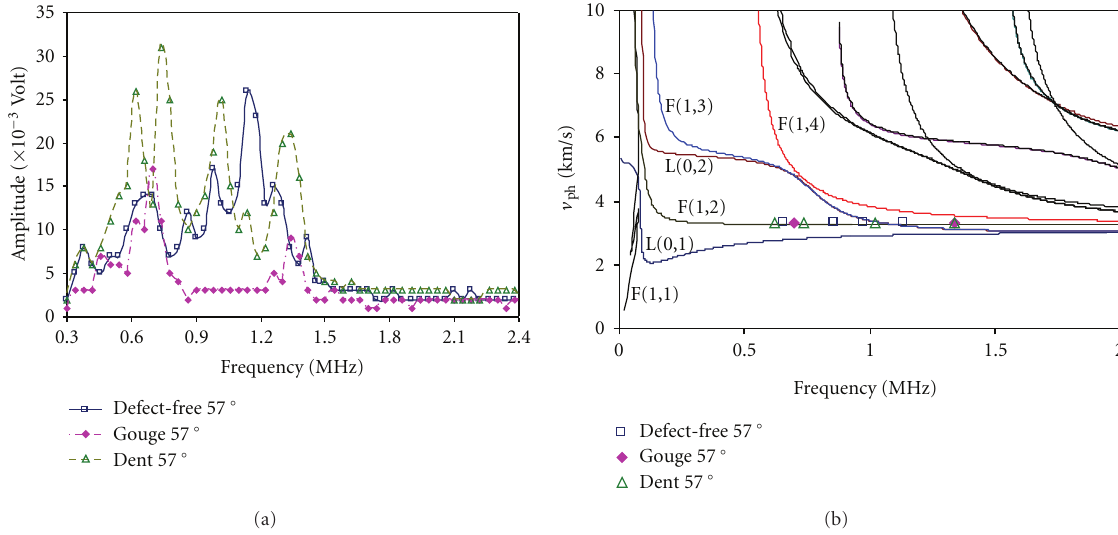
Figure 4: (a) experimental V ( f ) curves for defect-free and defective pipes when pipes are embedded in soil for 57 ◦ incident angle for defective and defect free pipes (b) theoretical phase velocity dispersion curves obtained for a steel pipe with experimentally obtained phase velocities for modes generating at 57 ◦ incident